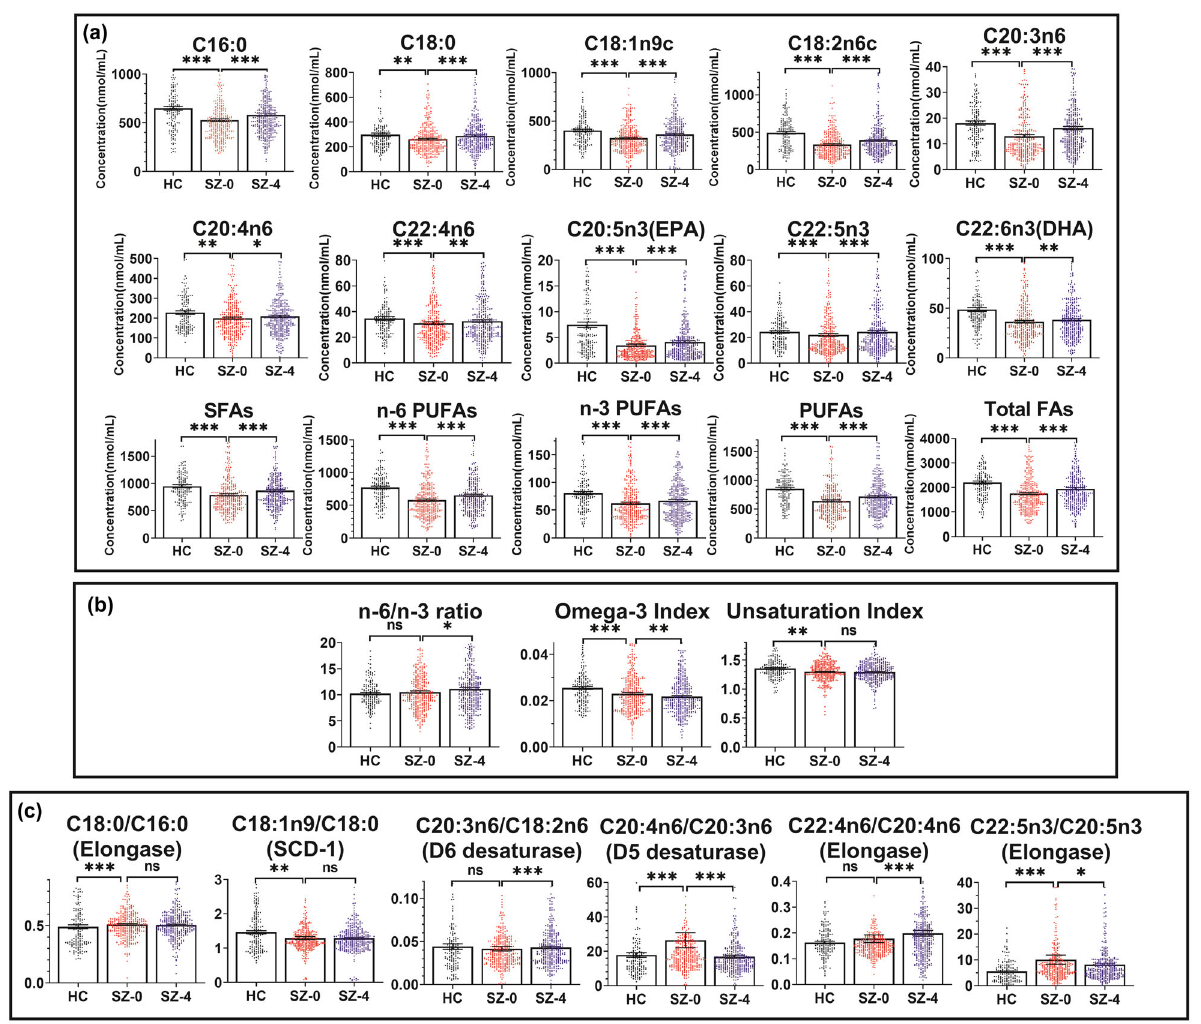
Fig. 2 Differences in membrane fatty acid levels and ratios between patients with schizophrenia at baseline (SZ-0) and healthy controls (HC) as well as changes after antipsychotic treatment (SZ-4). a Speci fi c fatty acids we measured and summations for SFAs, n-6 PUFAs, n-3 PUFAs, PUFAs, and total FAs; b n-6/n-3 ratio, omega-3 index and unsaturation index; c fatty acid ratios (markers of enzymes). SFAs, saturated fatty acids; PUFAs, polyunsaturated fatty acids; FAs, fatty acids; plots are shown as the means and standard errors; the Mann – Whitney test was used to analyze the variations between HC and SZ-0, and group pairwise differences between SZ-0 and SZ-4 were determined by the Wilcoxon signed rank test. * p < 0.05, ** p < 0.01, *** p <